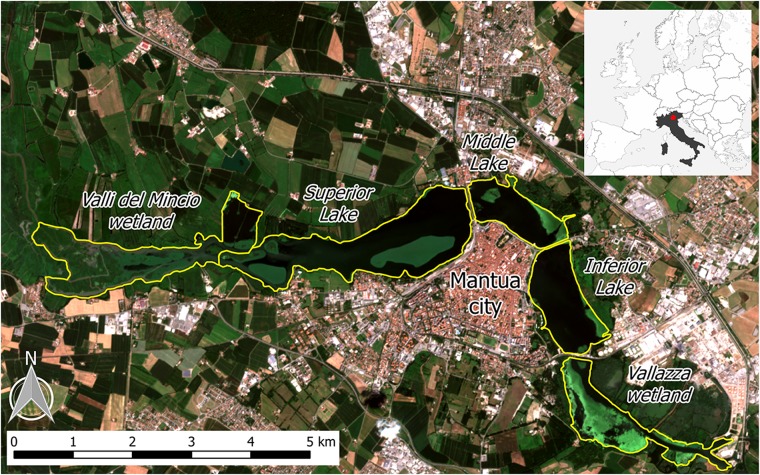
The Mantua lakes system, with the location of the study area in Italy (upper right box), and the different subsystems (lakes and wetlands) indicated. Background image is a Sentinel-2A satellite-acquired true color composite from 28 July 2016.